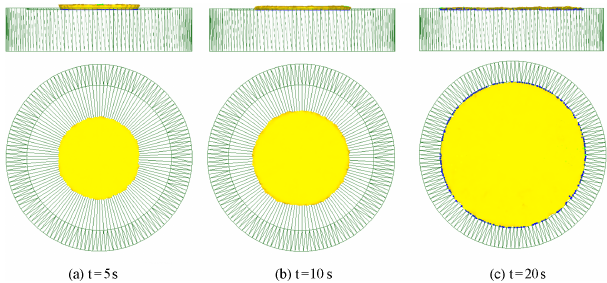
Figure 10. Deformation process of rotary forging with DSRs of a disc under the second deformation condition.